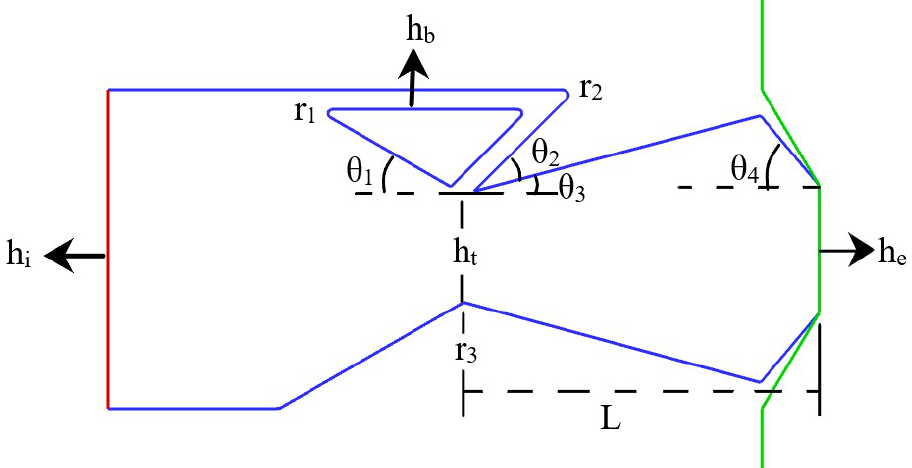
Figure 1. Configuration of BDTN. Table 1. The constant geometric dimensions and parameters adopted from Rui Gu [40].